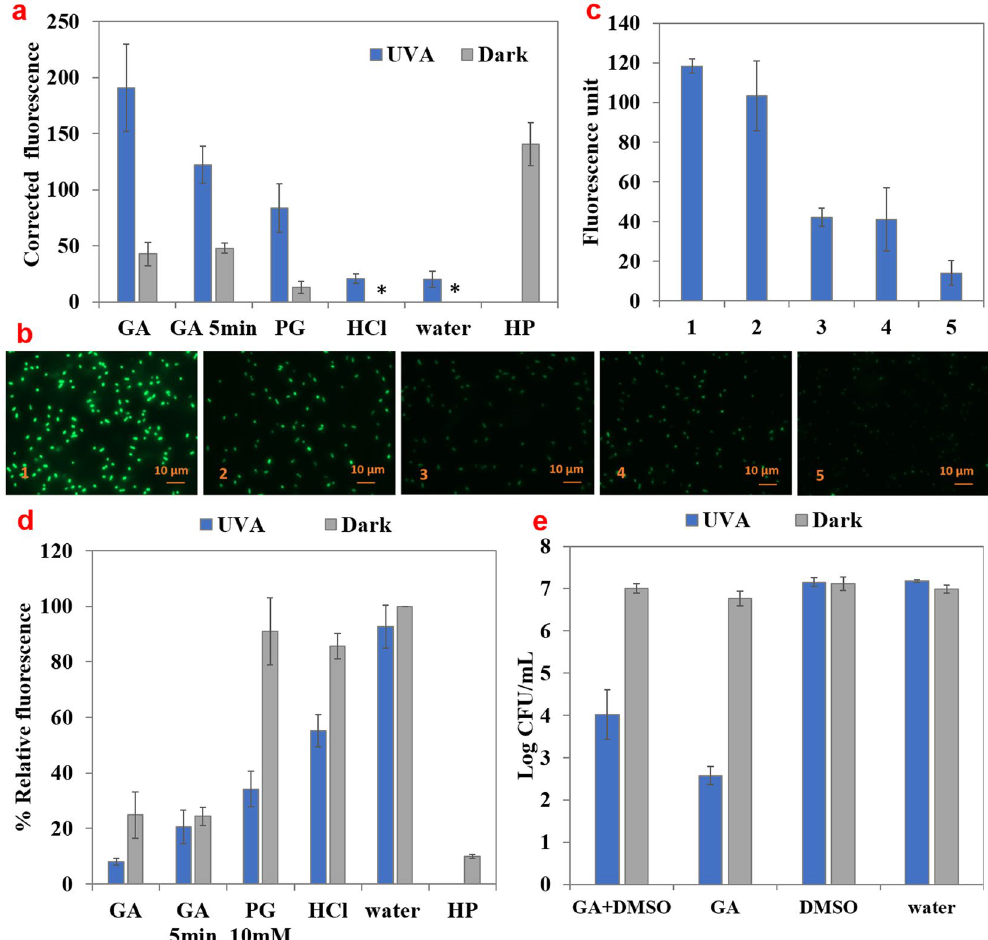
Figure 3. Measurement of oxidative stress experienced by bacteria by the select treatments. ( a ) Detection of reactive oxidative species (ROS) within E. coli O157:H7 using CellROX ® Reagent Green upon treatment by GA (15 mM), PG (10 mM), HCl (pH 3.1), water, or hydrogen peroxide (HP, 1.5%), in the absence or presence of UV-A light for 30 or 5 min. Absolute fluorescence values were corrected by subtracting the fluorescence values for samples incubated in water and in dark. * Indicates that corrected fluorescence value was zero. ( b ) Fluorescent microscopy images ( × 100) of bacteria incubated with CellROX ® Reagent Green and (1) 15 mM GA + UV-A, (2) 15 mM GA in dark, (3) HCl (pH = 3.1) + UV-A, (4) HCl (pH = 3.1) in dark, (5) DI water in dark. ( c ) Average maximum fluorescence intensity within the bacteria imaged using fluorescence microscopy. ( d ) Measurement of free thiols content from E. coli O157:H7 suspensions treated by GA (15 mM), PG (10 mM), HCl (pH 3.1), or water, with the presence or absence of UV-A light for 30 or 5 min. Hydrogen peroxide (HP, 1.5%), was used as a positive control. ( e ) Logarithmic reduction of E. coli O157:H7 by 15 mM GA + UV-A light, with or without 5% DMSO. Mean ±